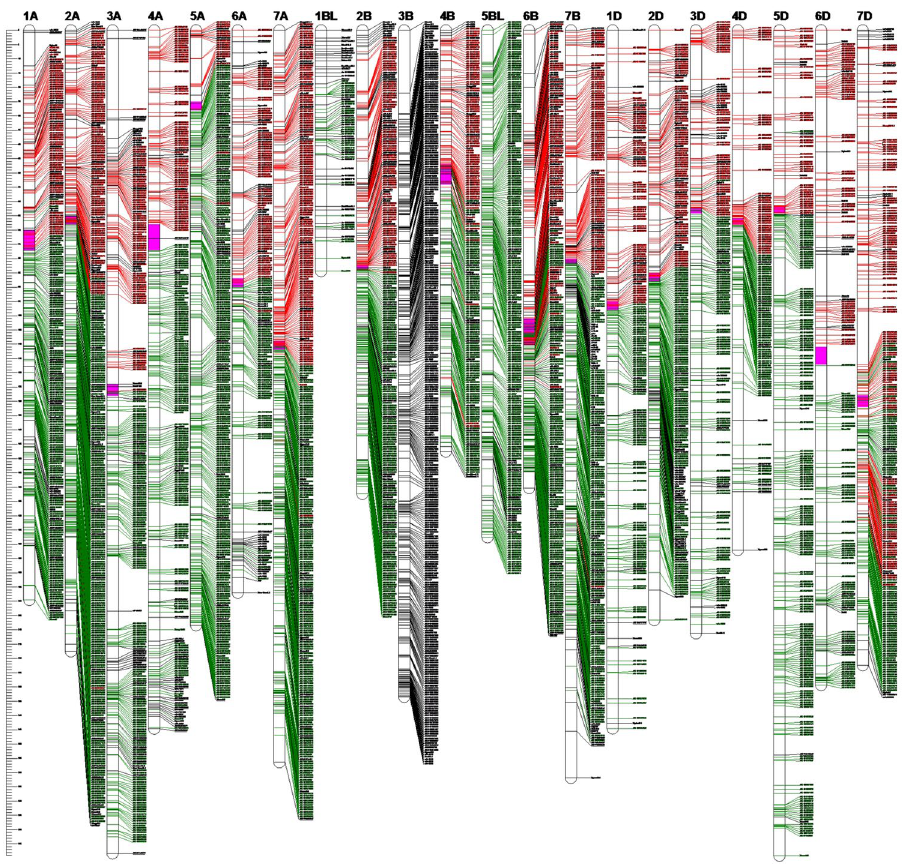
Figure 2. The high-density genetic map of wheat developed using an RIL population derived from the cross of cultivars KN9204 and J411. For the redundant loci that showed co-segregation in the 188 KJ-RILs, only one unique informative marker is shown in this figure. The approximate positions of the centromeres are indicated by pink . Short arms are at the top . The positions of the marker loci are indicated using a ruler on the left side of this figure. The names of the marker loci are listed to the right of the corresponding chromosomes. Loci in red were best hits to Chinese Spring (CS) contigs of the short arm of the corresponding chromosomes. Loci in green were best hits to CS contigs of the long arm of the corresponding chromosomes. Loci in black were unknown. Contigs from chromosome 3B were not separated into short/long arm bins, as individual arm datasets were not generated for this chromosome in the Chromosome Survey Sequence (CSS)